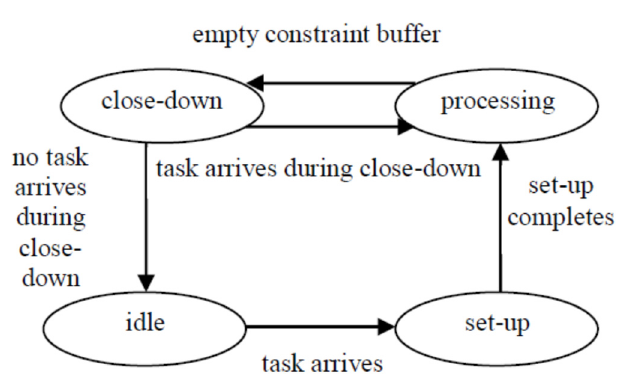
Figure 1. Phase transition diagram of the model with shut-down and setup times [63].